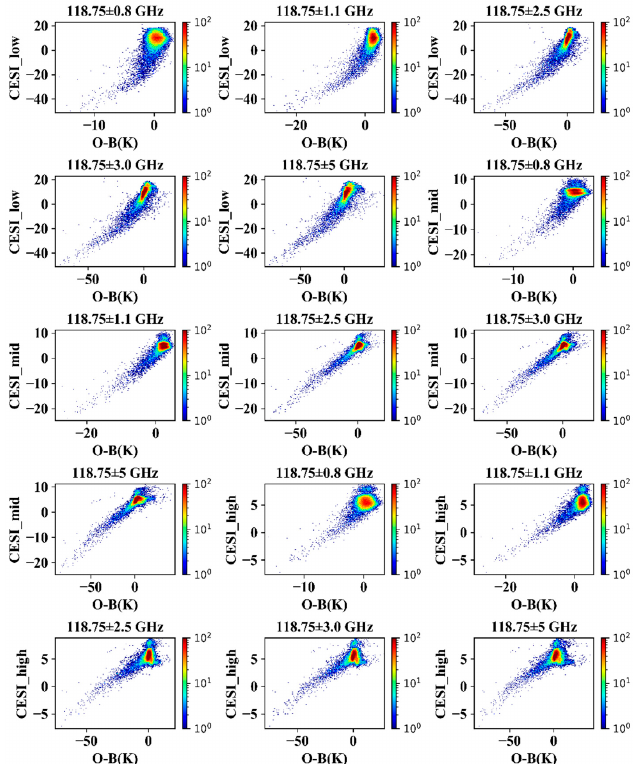
Figure 12. Scatter density plots of cloud scattering index versus five channel observation versus O − B values on the ocean surface for different height layers, where the color scale indicates the density of points.